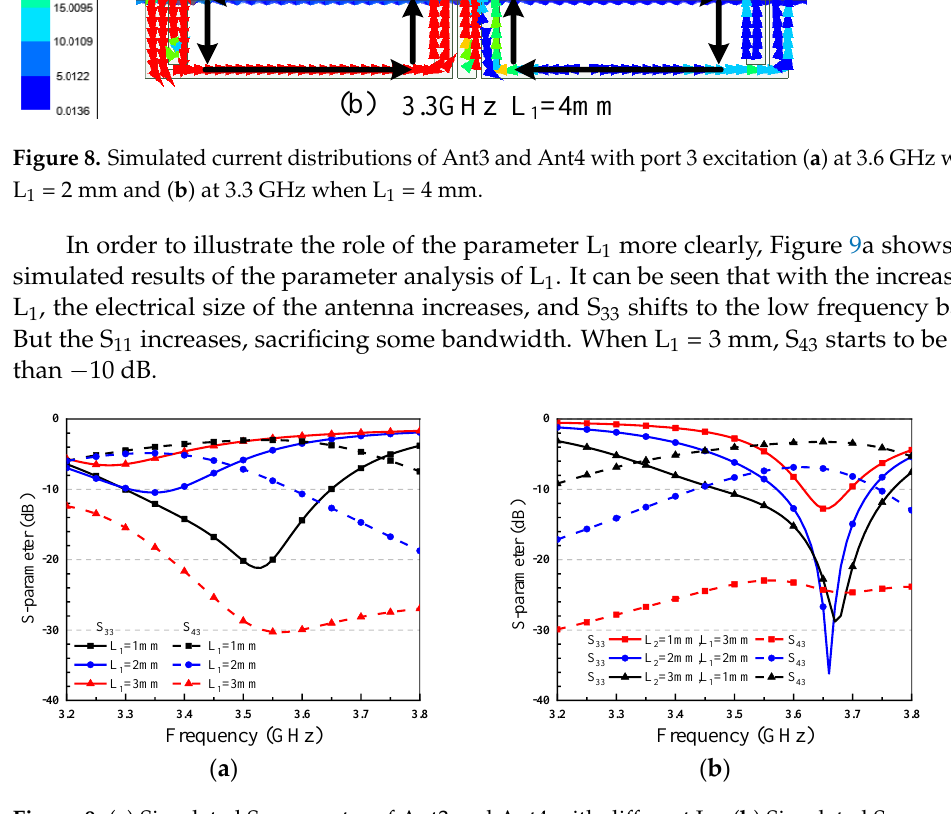
Table 1. Comparison of the proposed antenna pair with previous works.